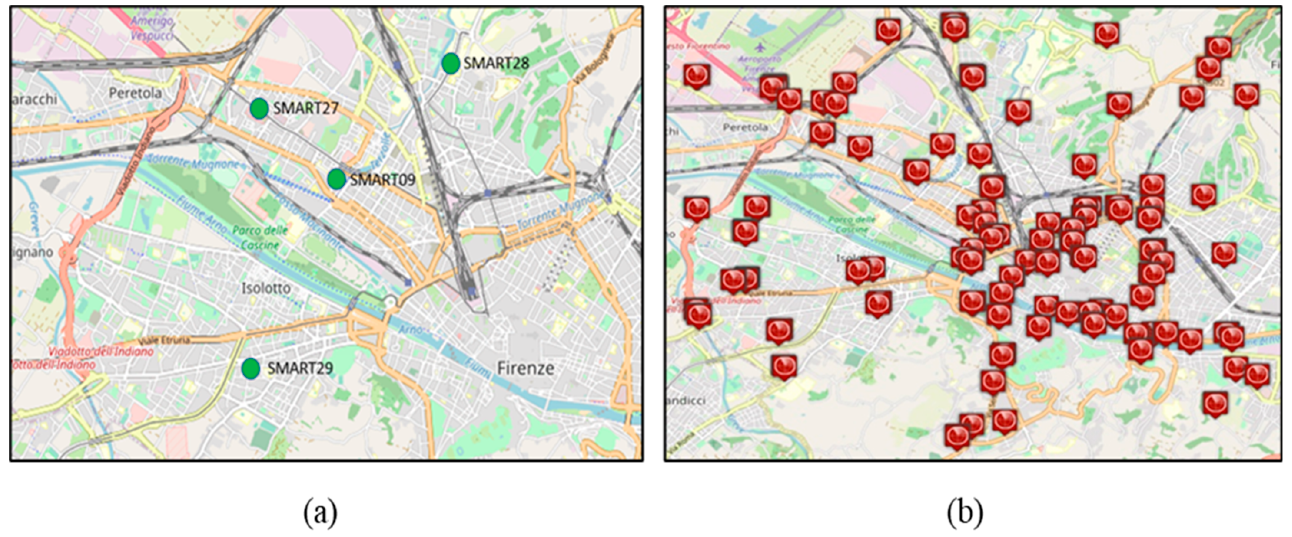
Figure 2. The left side depicts the locations of the air-quality sensors considered in the present work (4 of the 10 in the area of Florence). The right side depicts the map of the traffic sensors in Florence Municipality. ( a ) CO 2 sensors; ( b ) traffic flow sensors.